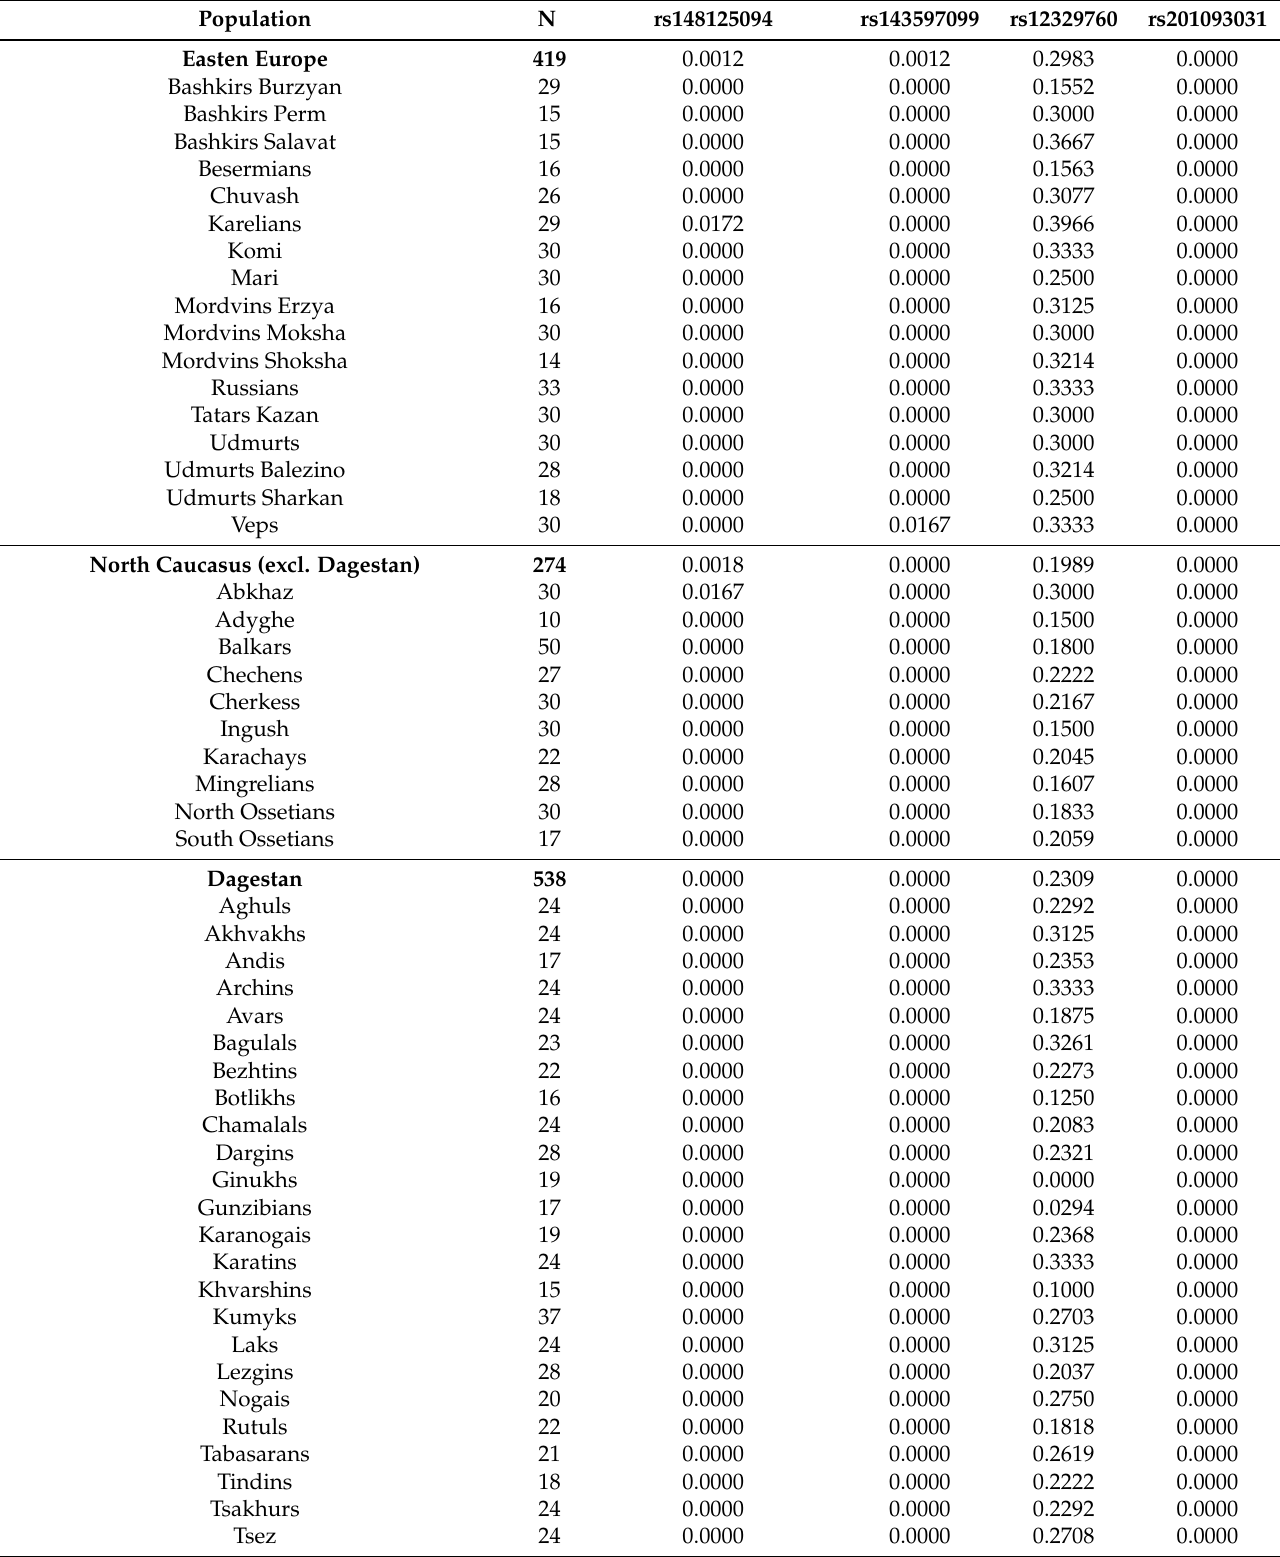
Table 3. Frequency of TMPRSS2 missense mutations in North Eurasian population. AZ General information about the region from individual populations was highlighted in bold.